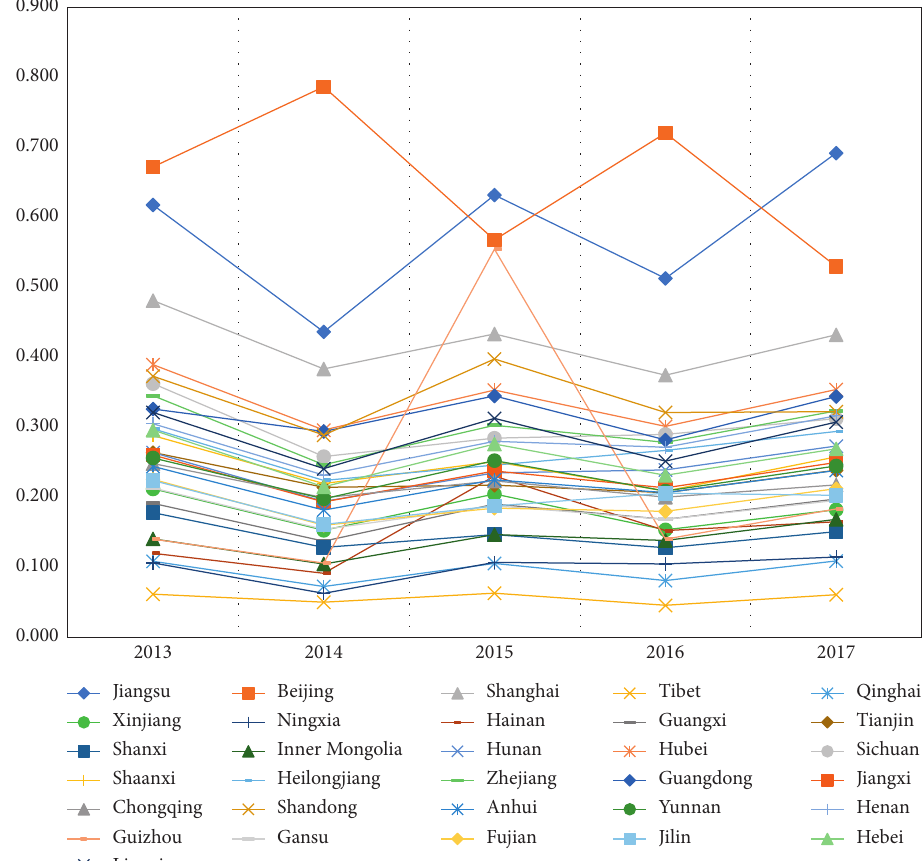
Figure 3: Temporal changes of